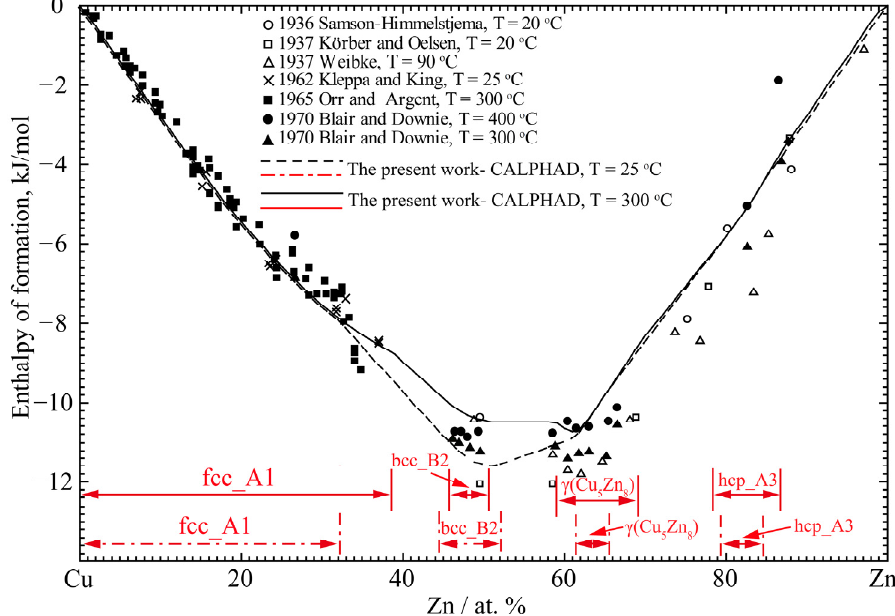
Figure 5. The calculated standard enthalpies of formation at 25 and 300 °C in the Cu-Zn system compared with the experimental data from refs. [60,71–75].